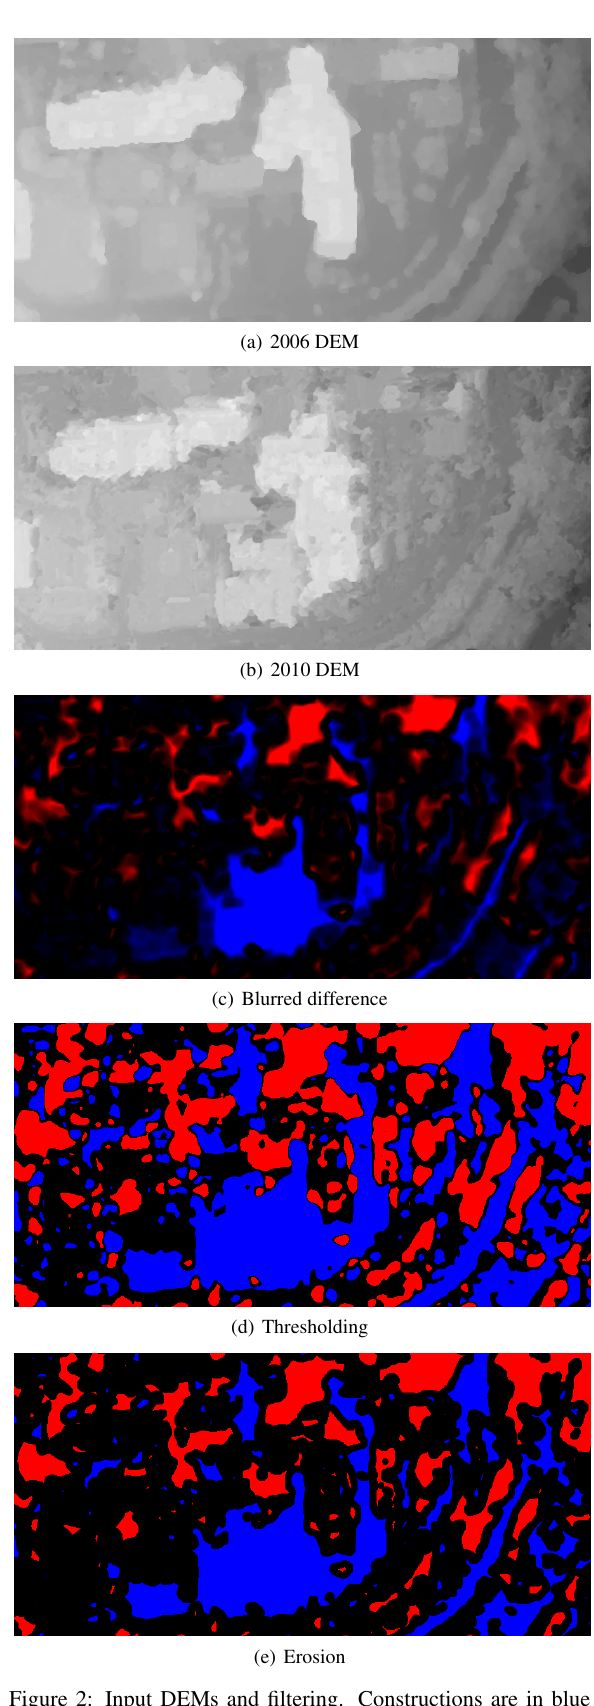
Figure 2: Input DEMs and filtering. Constructions are in blue and destructions in